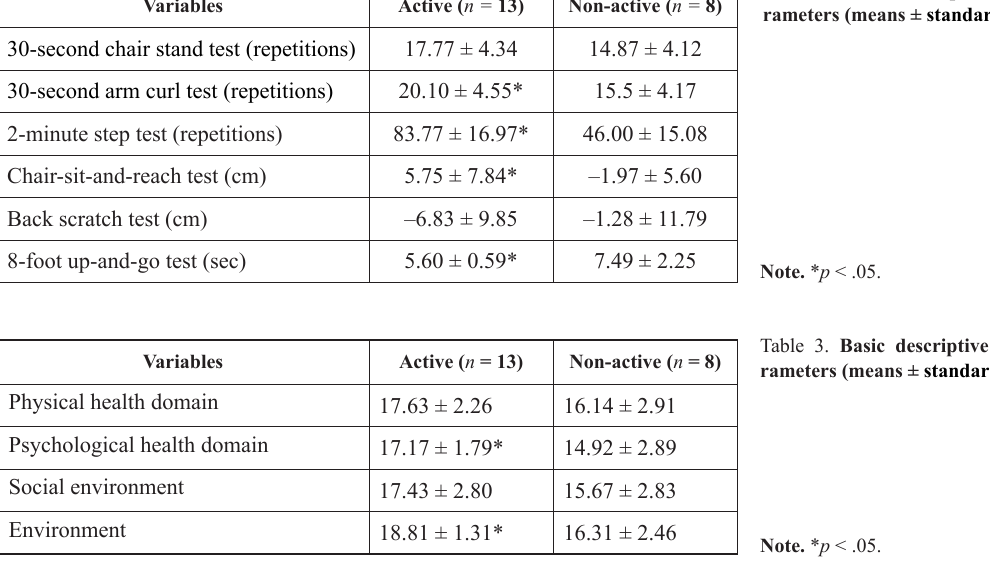
Table 2. Basic descriptive physiological pa - rameters (means ± standard deviations)